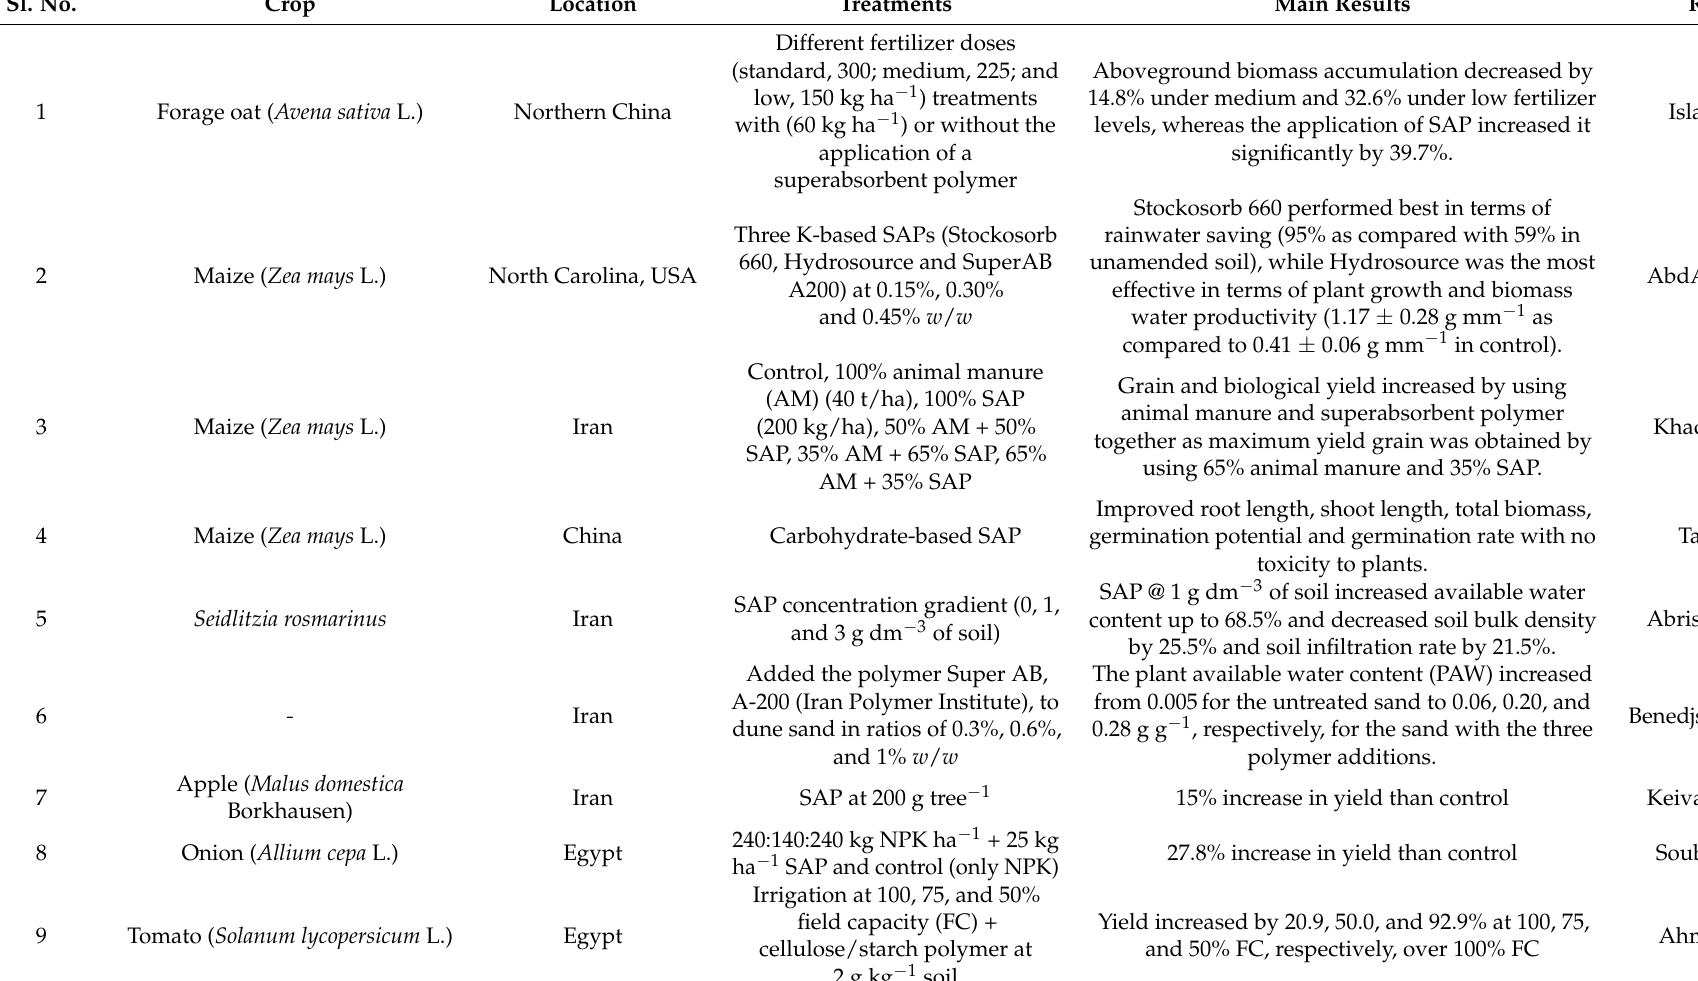
Table 2. Effect of superabsorbent polymers (SAPs) on crop growth in water-limited environments. Sl.